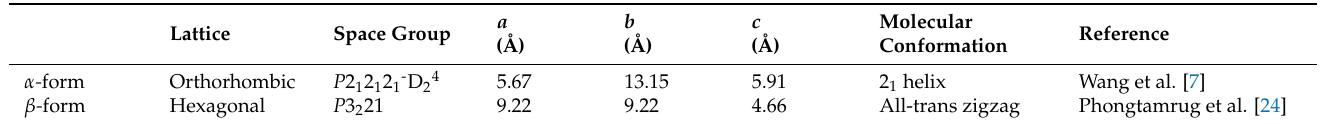
Table 1. Crystallographic data, lattice parameters and molecular conformation for the α - and β -crystals of